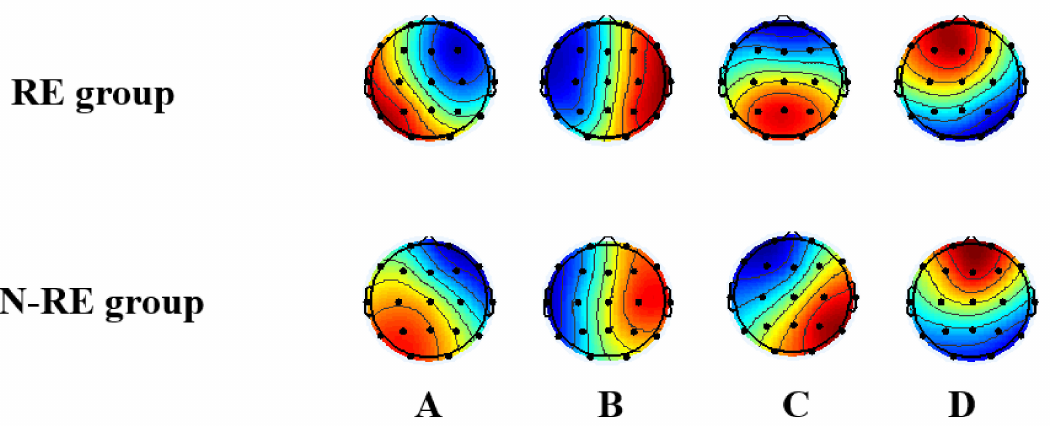
Figure 3. Group mean maps showing the spatial changes in each microstate topology class (A, B, C, D) in responsive and non-responsive groups.